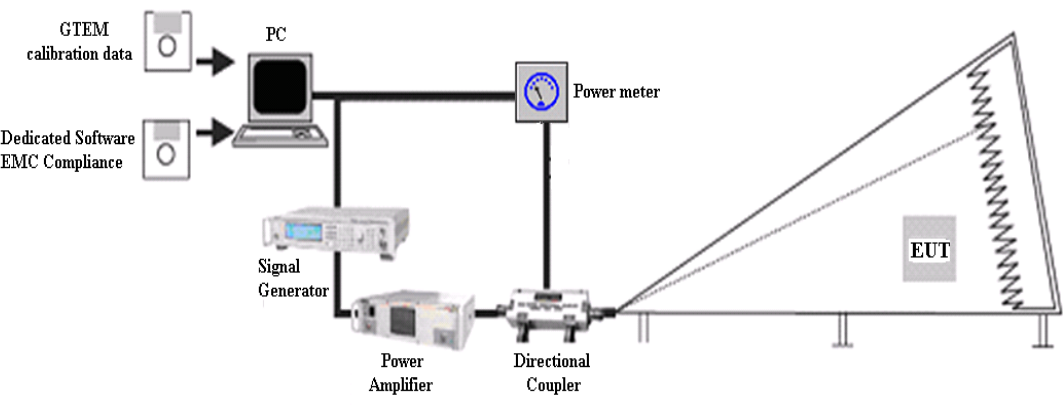
Figure 19. Calibration equipment used to perform immunity tests [32].